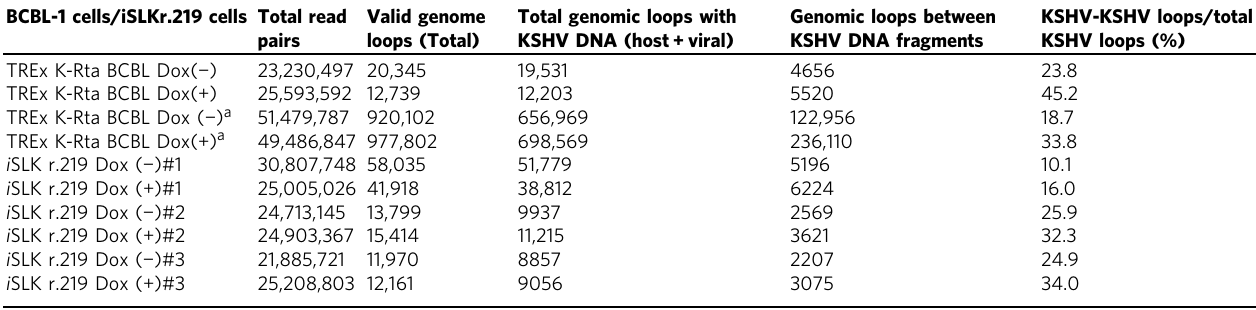
Table 1 Capture Hi – C sequencing reads and genomic links of ligation products BCBL-1 cells/iSLKr.219 cells Total read